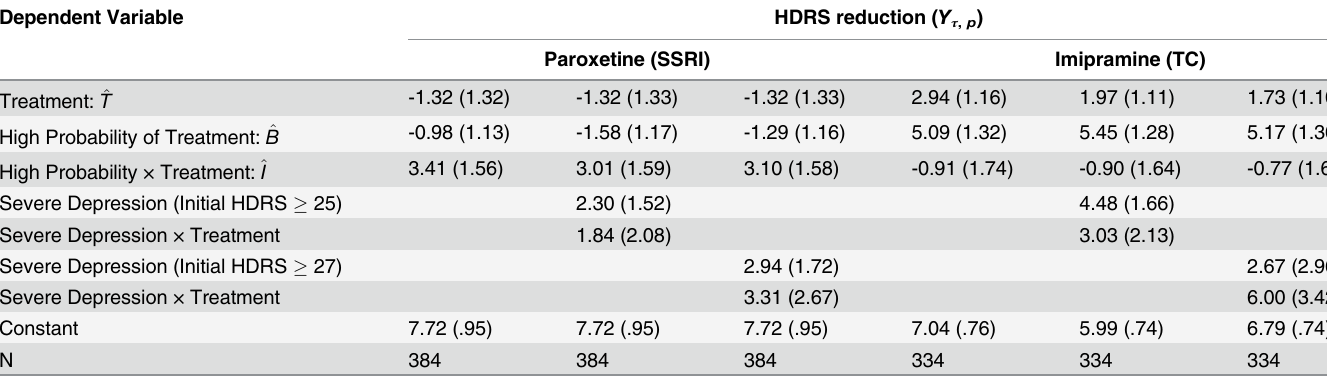
Table 2. Controlling for the effects of initial severity of depression in anti-depressant trials.